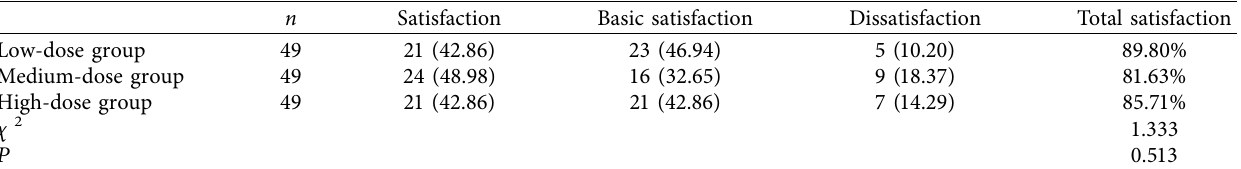
Table 3: Comparison of delivery